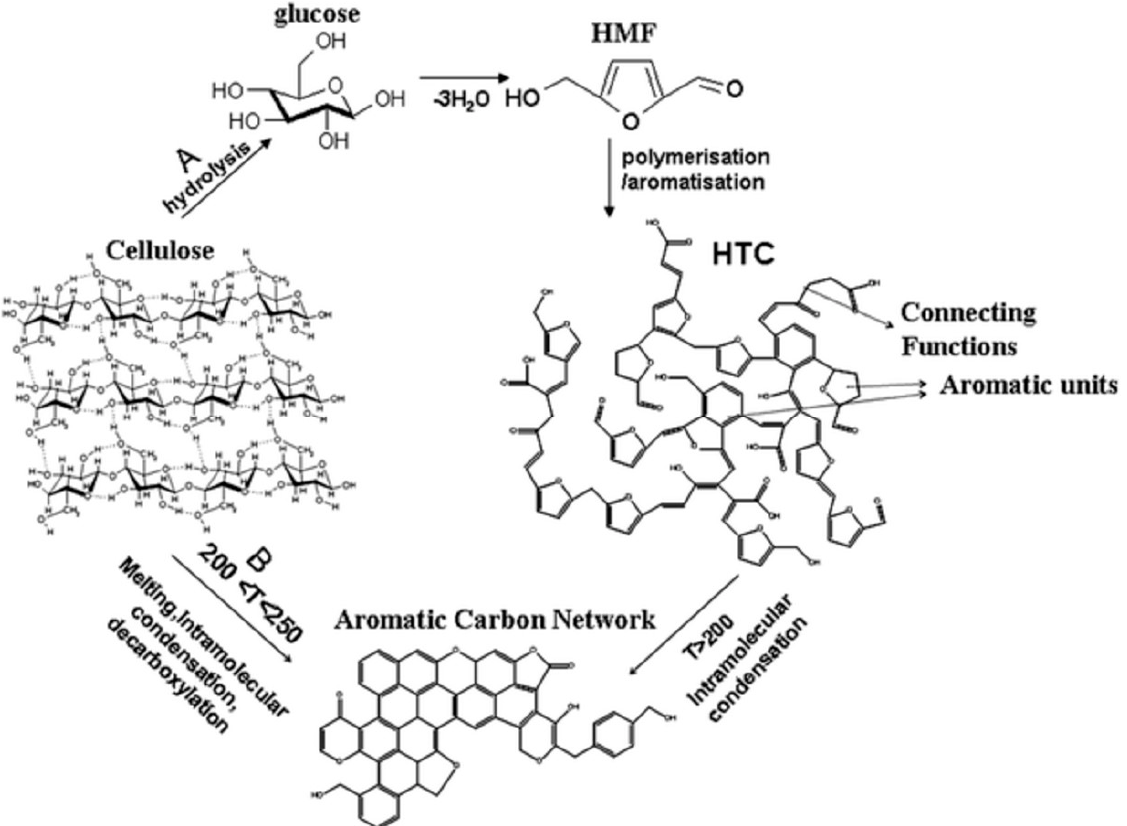
Figure 2. Conversion of cellulose to aromatic carbons under hydrothermal carbonization (HTC) conditions (reproduced from [22], with permission from The Royal Society of Chemistry, 2014).